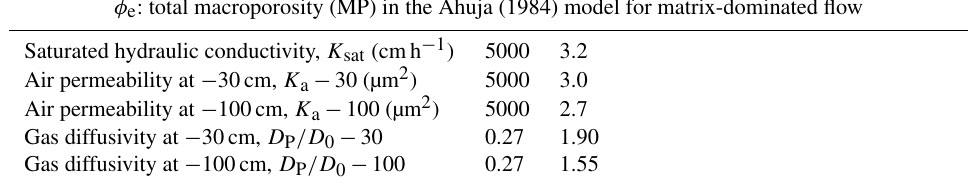
φ e : total macroporosity (MP) in the Ahuja (1984) model for matrix-dominated flow Saturated hydraulic conductivity, K sat (cmh − 1